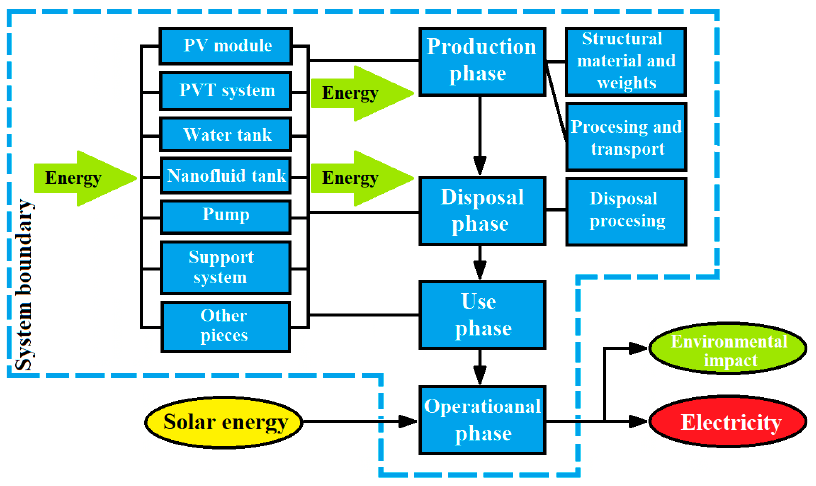
Figure 3. Flow chart of the experimental setup for the PV module and PV/T collector.